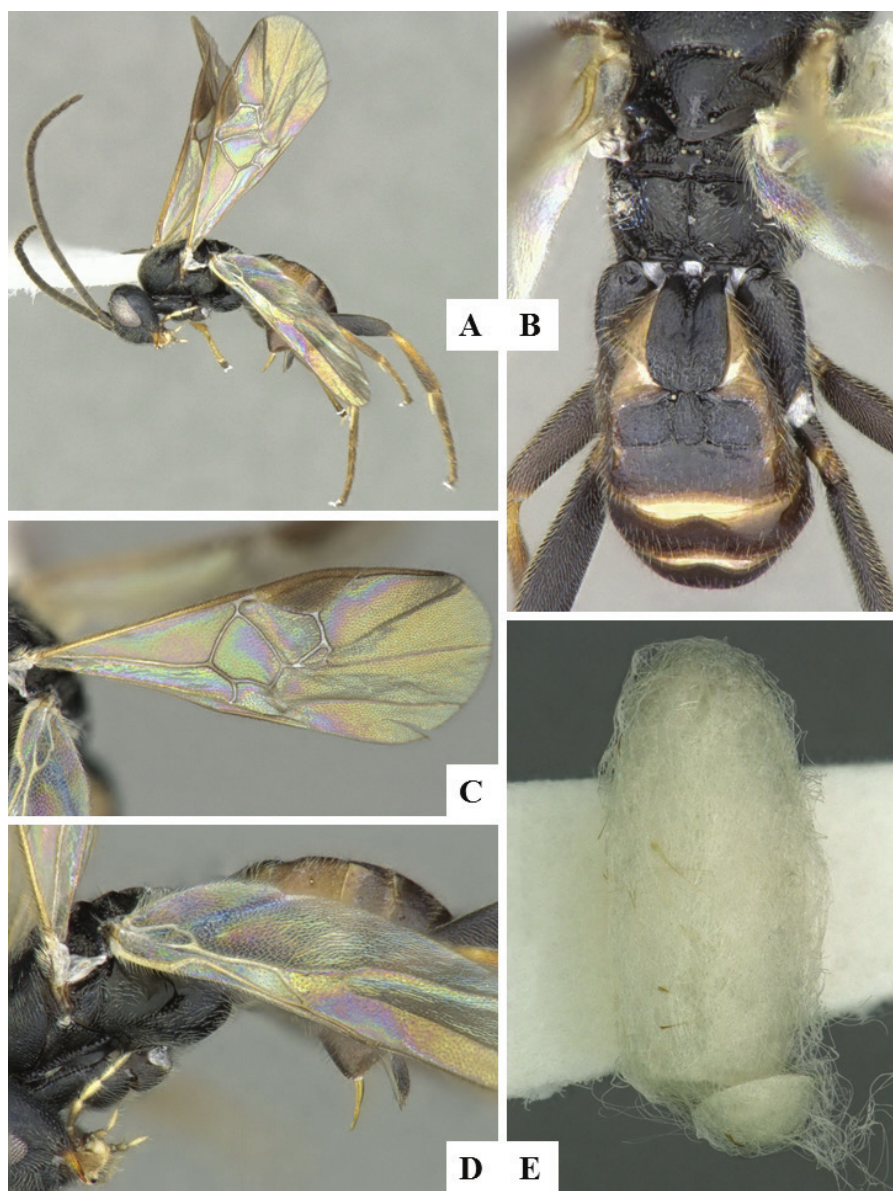
Figure 17. Diolcogaster claritibia. A Habitus, lateral B Mesosoma (partially) and metasoma dorsal C Wings D Mesosoma (partially) and metasoma, lateral E